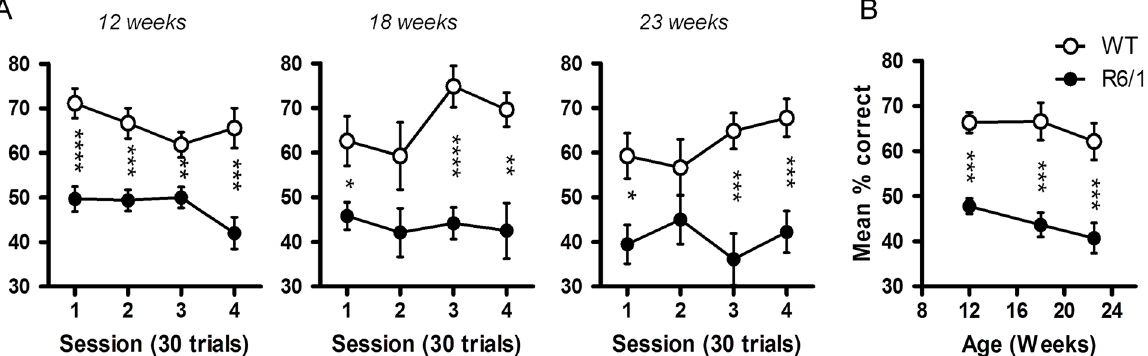
Fig 8. Reinforced spatial alternation in T-maze in R6/1 mice. Mean (SEM) percent correct for 4 consecutive sessions (30 trials/session) at 12, 18 and 23 weeks of age (A) and averaged scores for 4 sessions at each age (B). * R6/1 mice significantly different from age-matched WT littermates at p < .05, ** at p < .01, *** at p < .001 and **** at p <